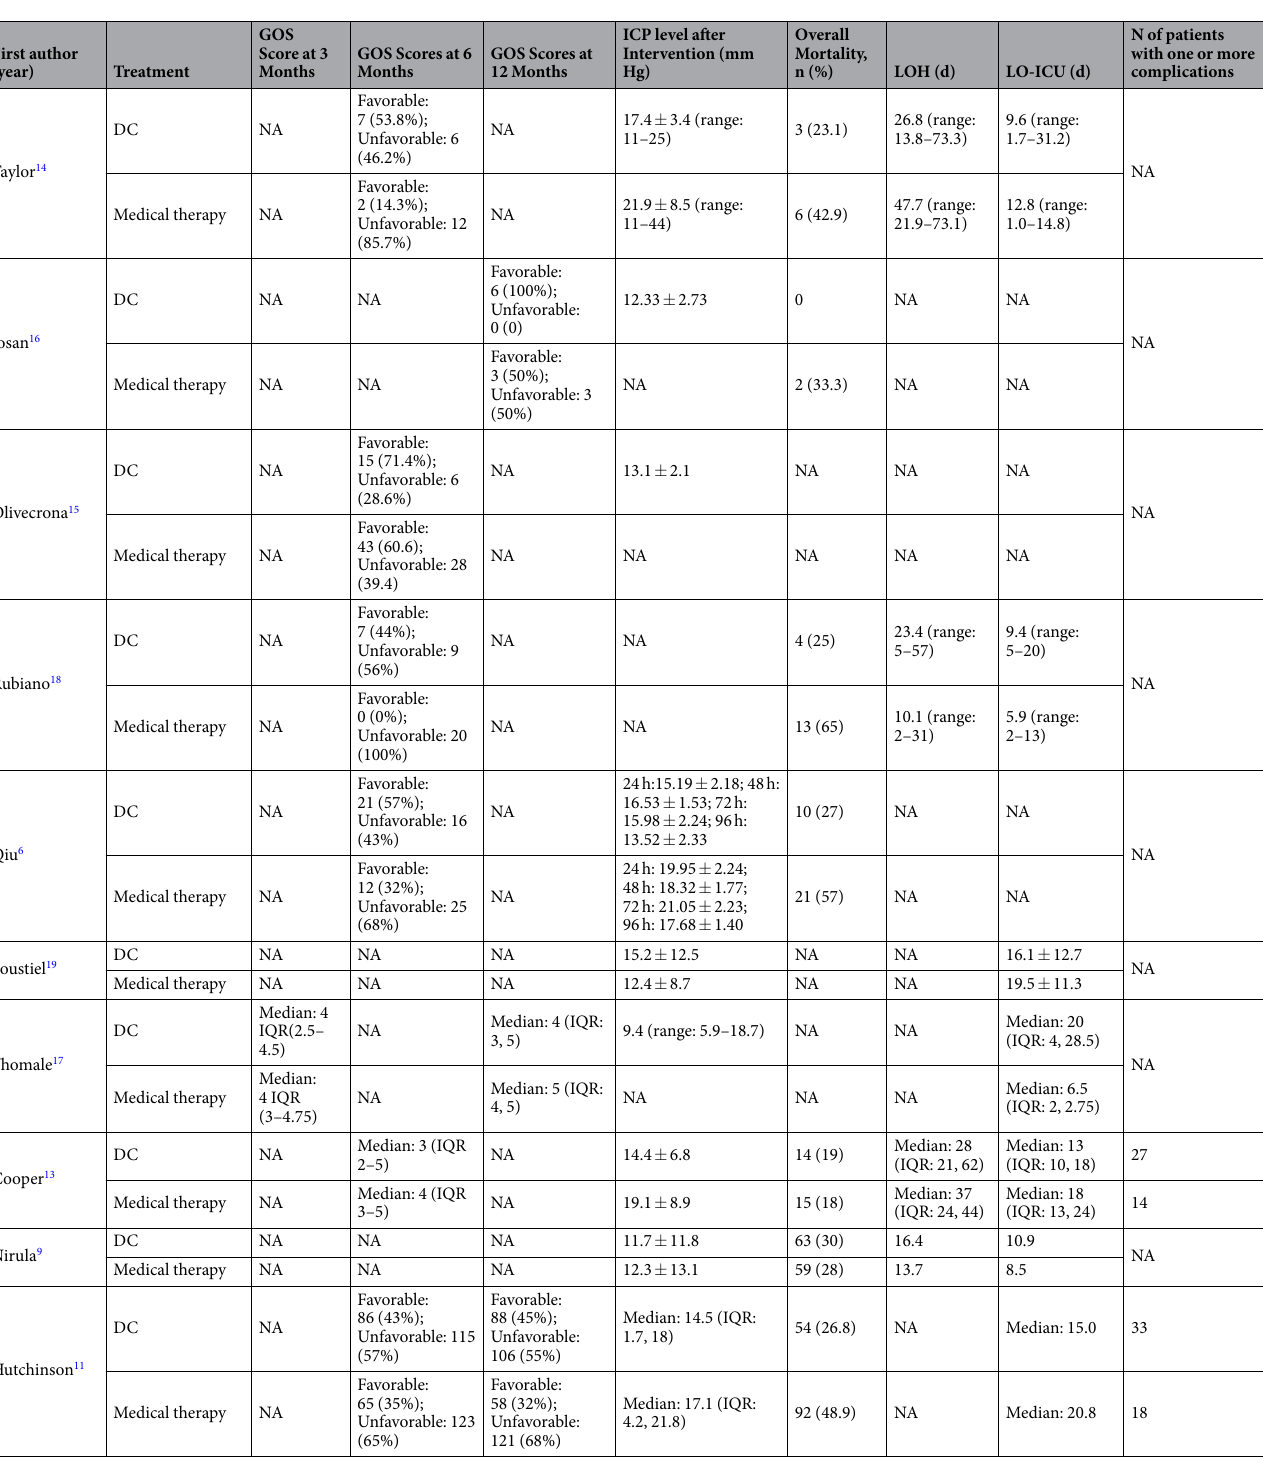
Table 2. Outcomes of included studies. DC, Decompressive Craniectomy; ICP, Intracranial Pressure; ICU, intensive care unit; IQR, Interquartile Range; GOS, Glasgow Outcome Scale; LOH, Length of Hospitalization; LO-ICU, Length of ICU Stay; NA, Not